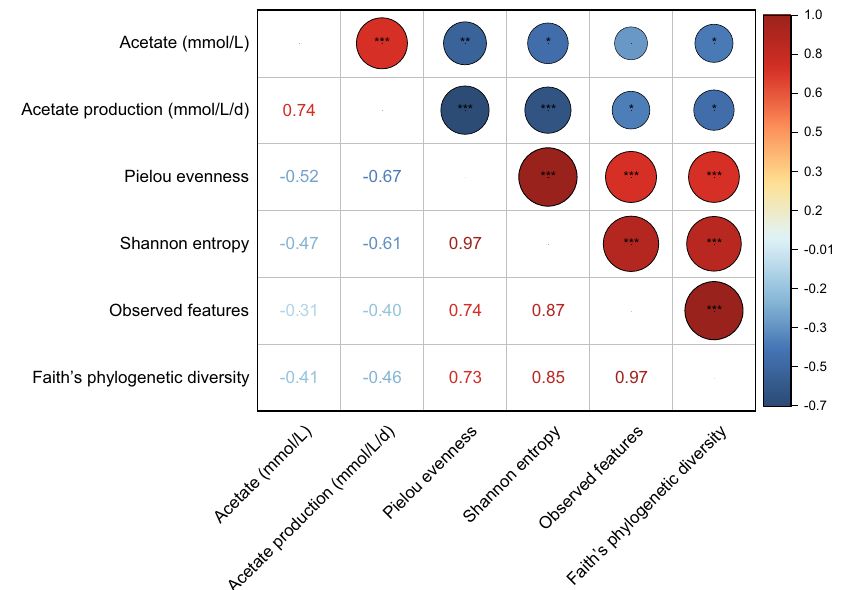
Fig. 6 Pearson correlation between alpha diversity indexes and acetogenic performances. The size of the circle represents the size of the absolute value of the index and the color of the circle represents the value of the index. Red is positive and blue is negative. The star represent the signi fi cant